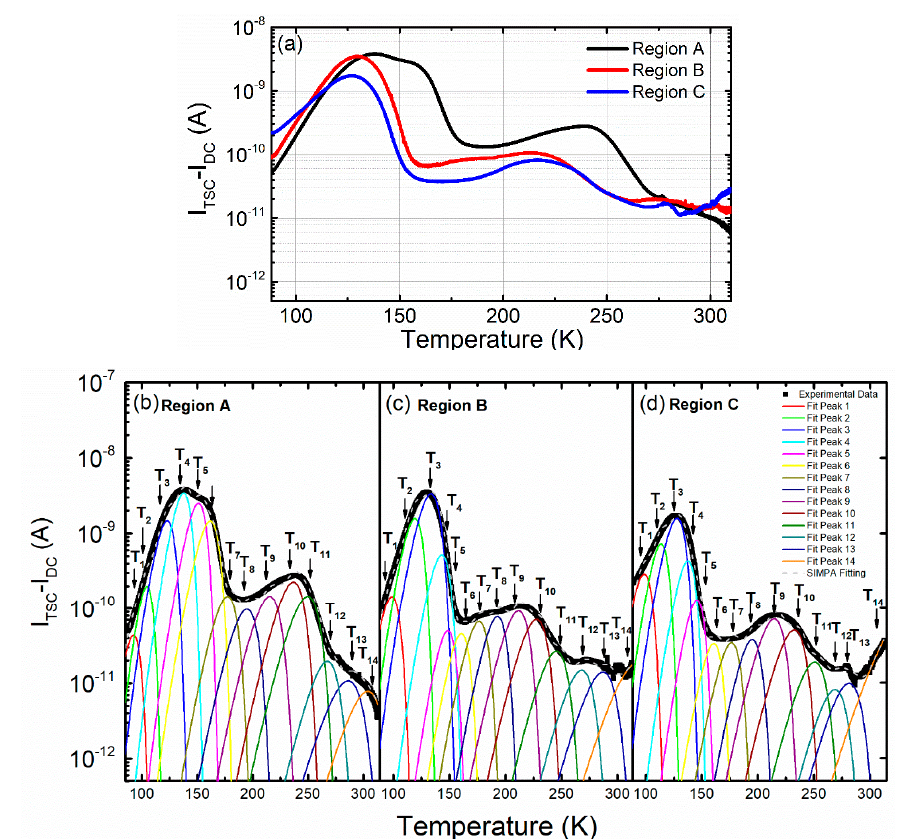
Figure 7. Thermally stimulated current (TSC) spectra with the simultaneous multiple peak analysis (SIMPA) fitting results of the three typical regions in the experimental CdZnTe sample. ( a ) The overview of TSC spectra; ( b – d ) the SIMPA fitting results of region A, region B and region C, respectively.